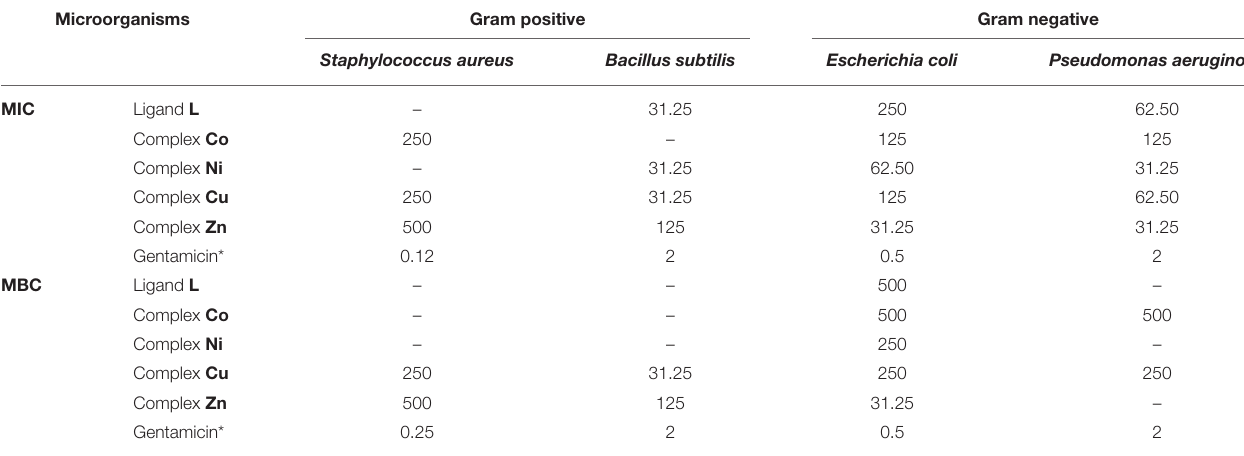
The antibacterial activity is expressed as the MIC and MBC (ppm). MIC, minimum inhibitory concentration; MBC, minimum bactericidal concentration. * Gentamicin used as standard control for bacteria.